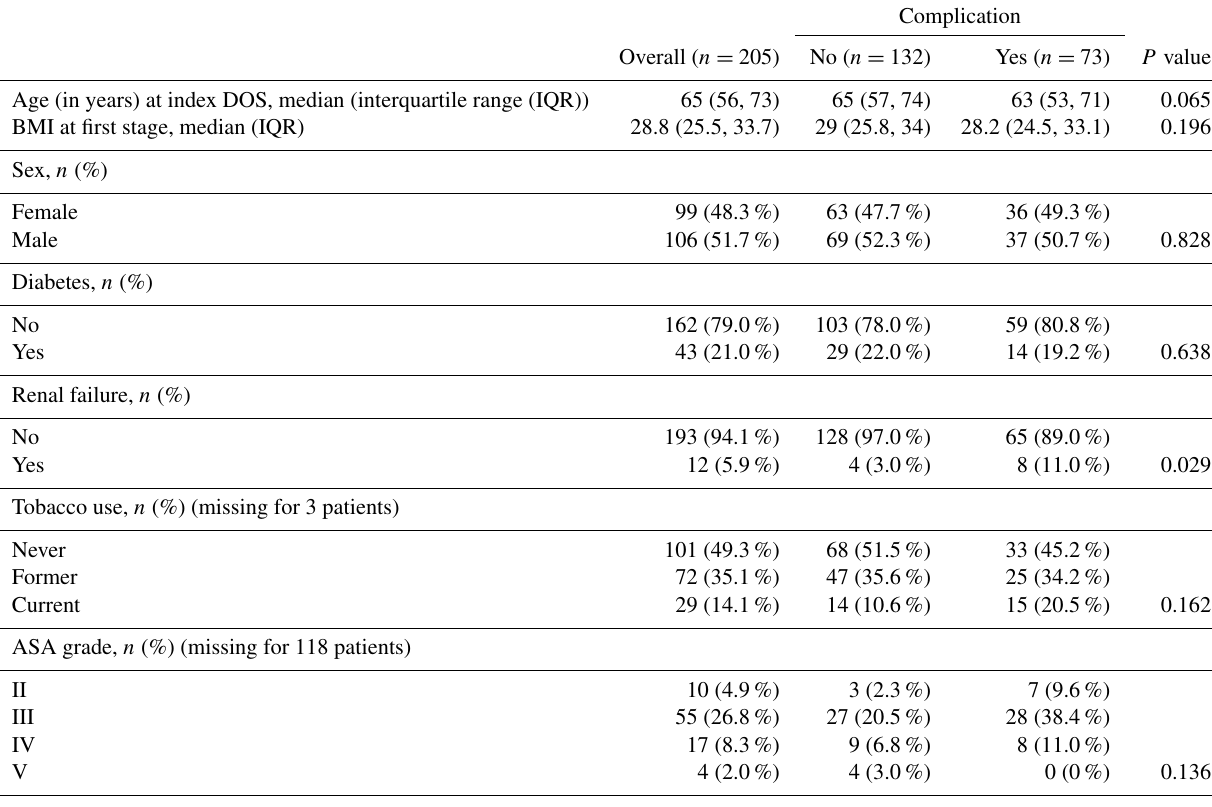
Table 1. Demographics and comorbidities between patients who had a complication and did not have a complication following two-stage exchange arthroplasty. Note that DOS represents date of